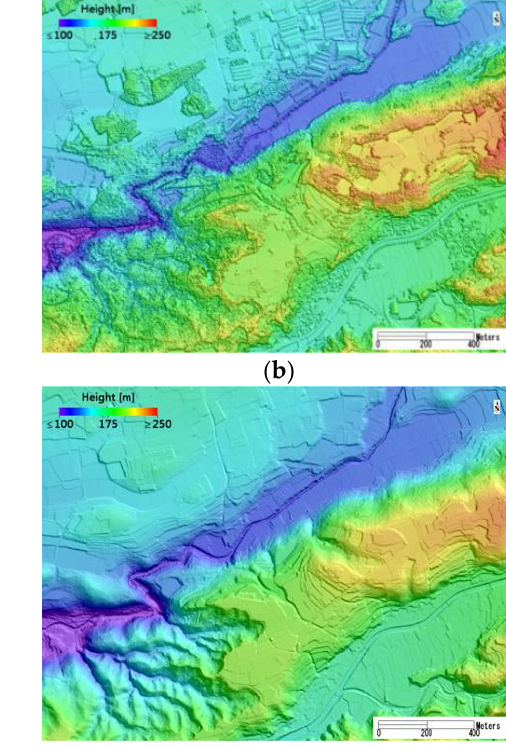
Figure 3. Timeline of the 2016 Kumamoto earthquake event and the used Lidar data.